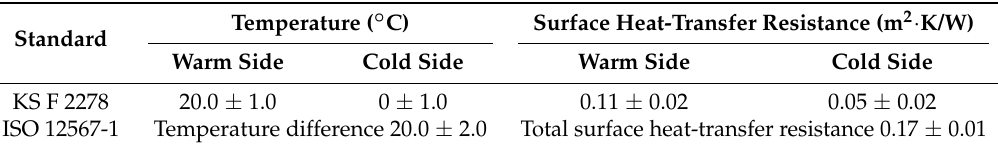
Table 1. Boundary conditions of KS F 2278 and ISO 12567-1.